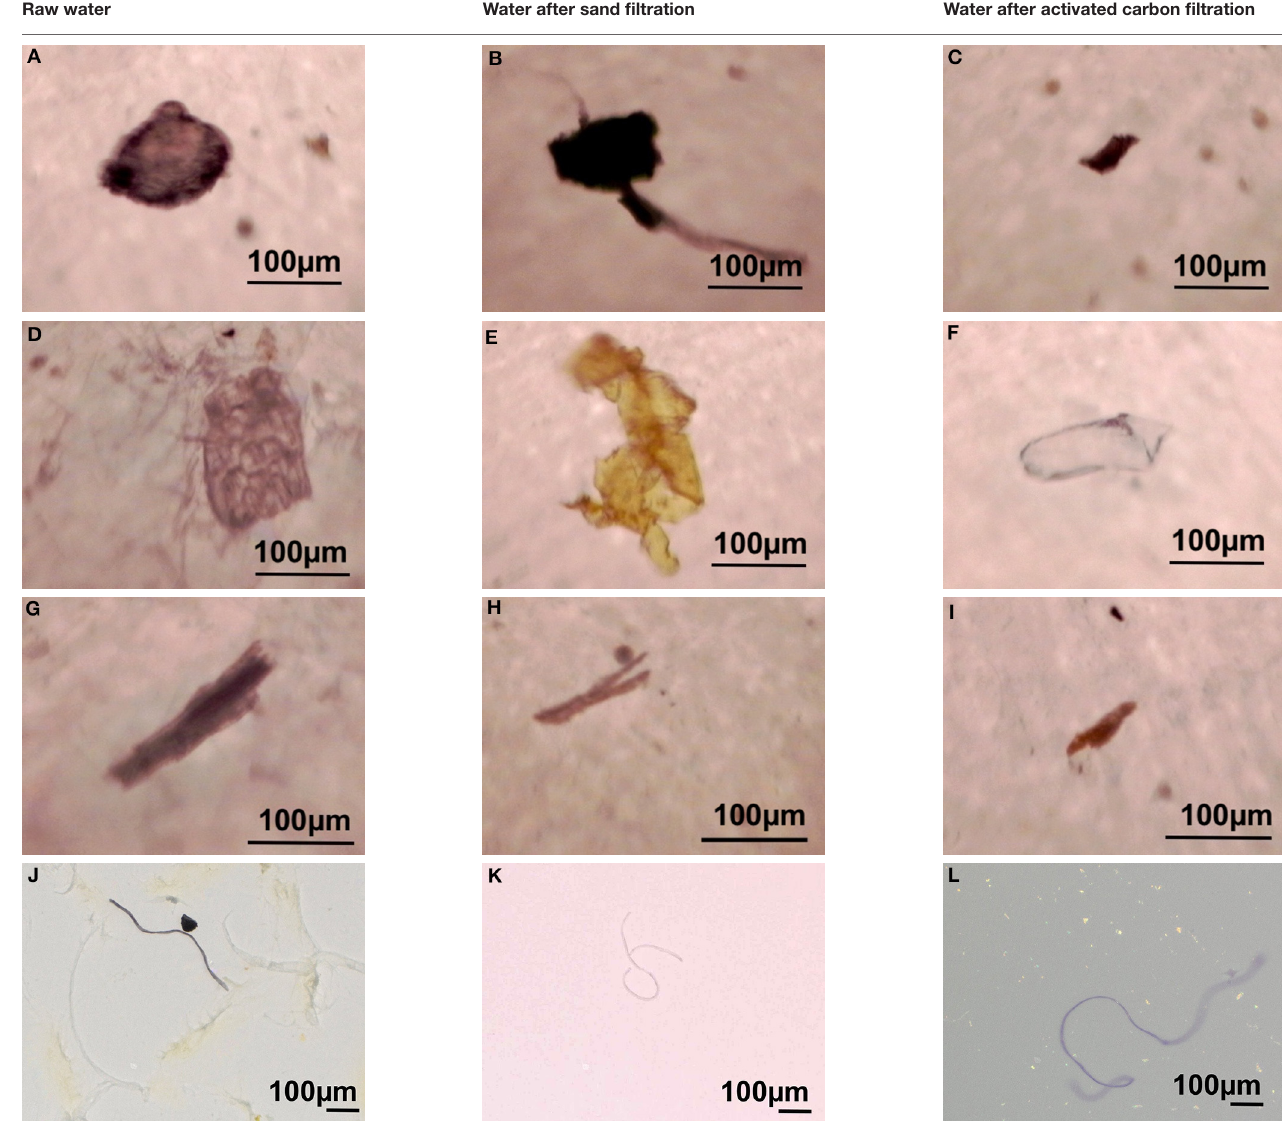
TABLE 1 | Examples of MPs (A–F) and synthetic fibres (G–L) pictures obtained with IR microscope (A–I) and optic microscope (H–L) found in raw water (left column), after sand filtration (middle column), and after activated carbon filtration (right column). Raw